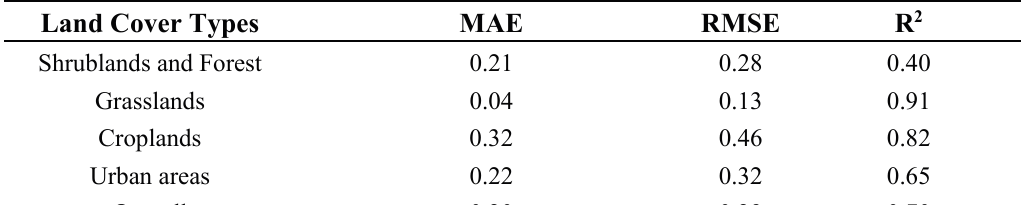
Table 4. Error analysis of the produced daily cloud-free FSC products compared with OLI image. Land Cover Types